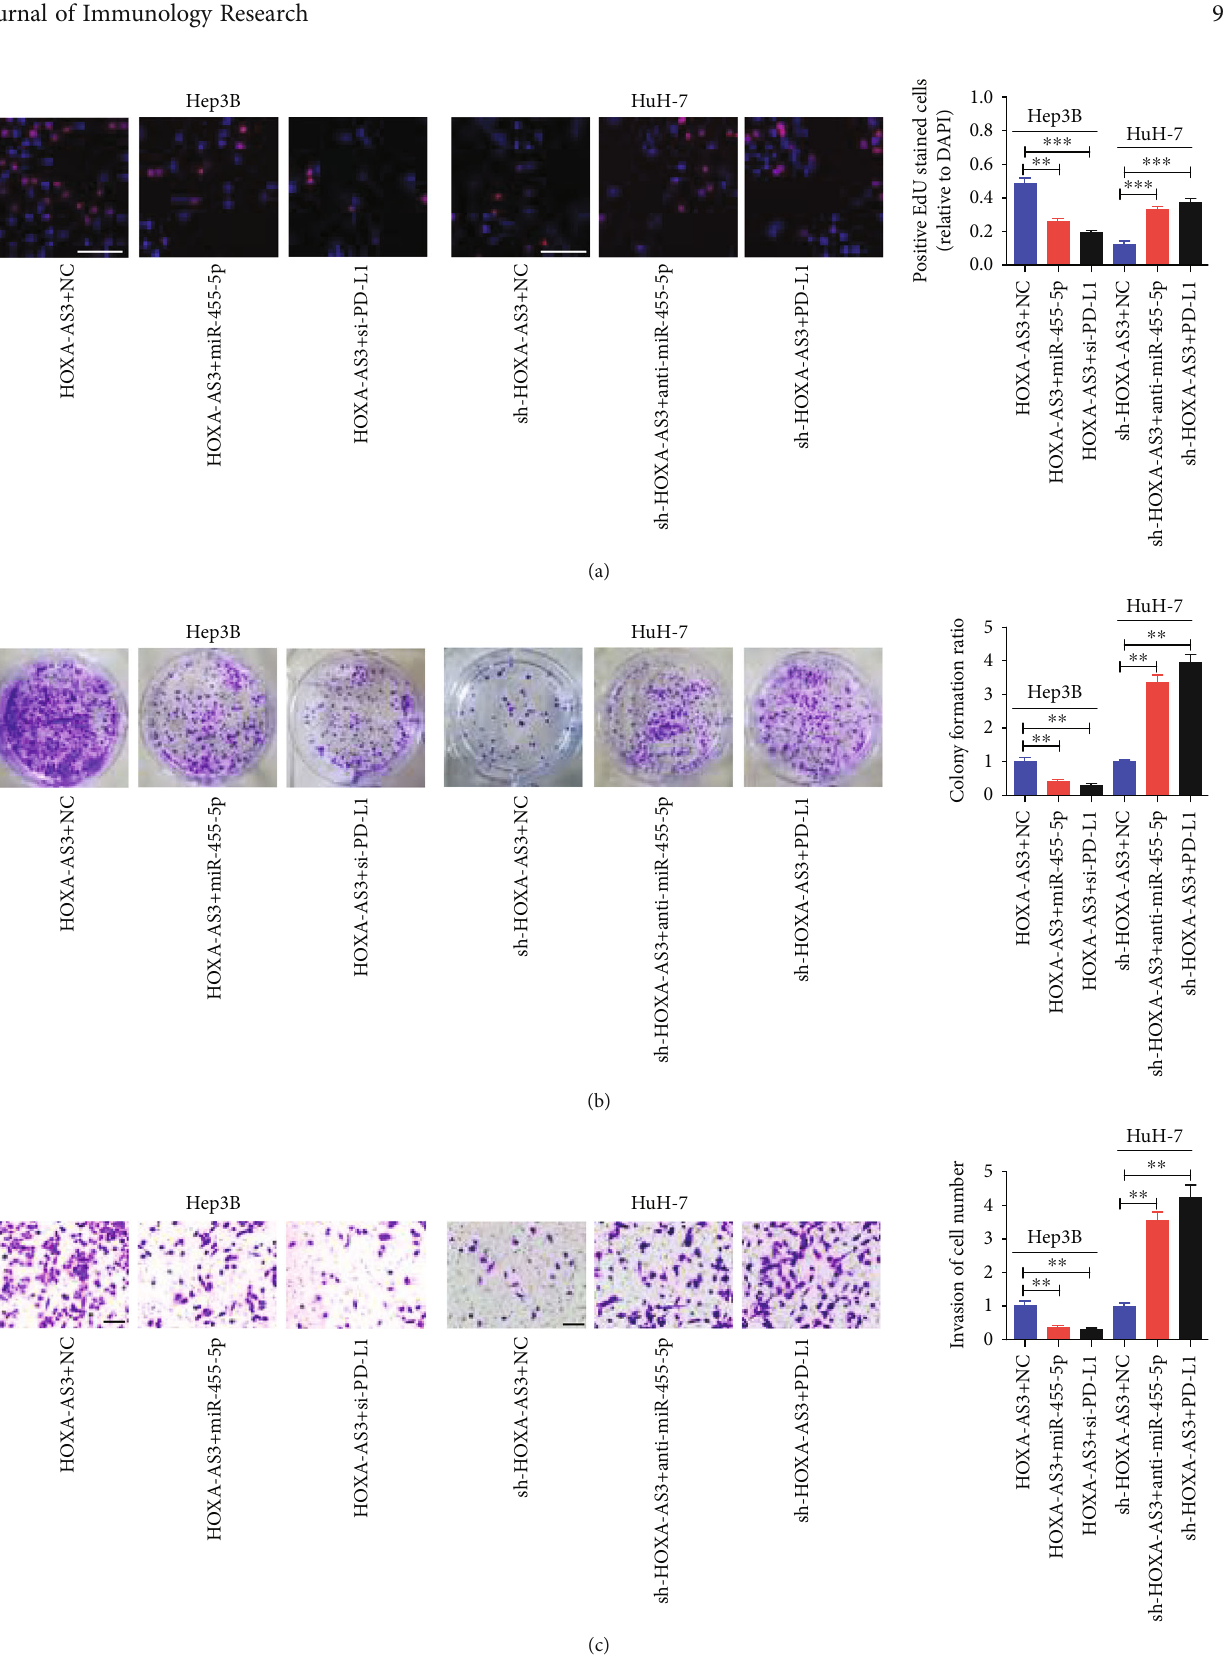
Figure 6: HOXA-AS3 modulates HCC cell proliferation and invasion via miR-455-5p/ PD-L1 axis. (a) EdU ( bar = 100 μ m), and (b) colony formation assays assessing the proliferation and colony formation of HuH-7 and Hep3B cells. (c) Images of HuH-7 and Hep3B cells by invasion assay ( bar = 100 μ m). Data are reported as the mean ± SD of three separate experiments; ∗∗ P < 0 : 01 and ∗∗∗ P < 0 : 001